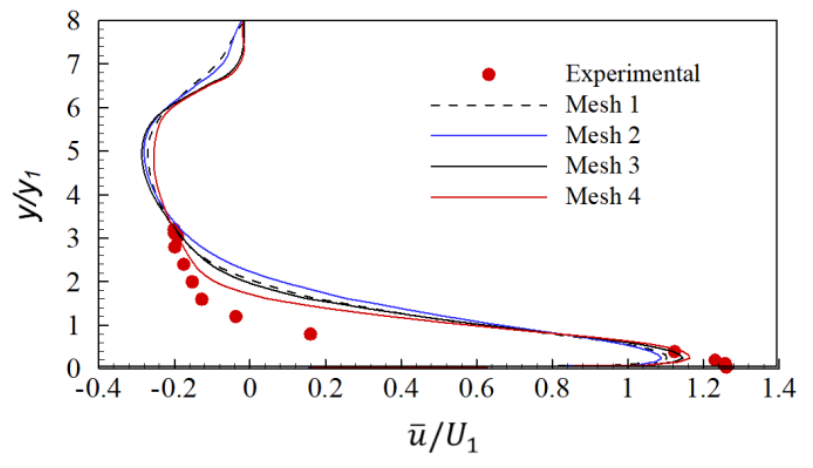
/ y = 5 and z / b = 0.4 for di ff erent mesh 1